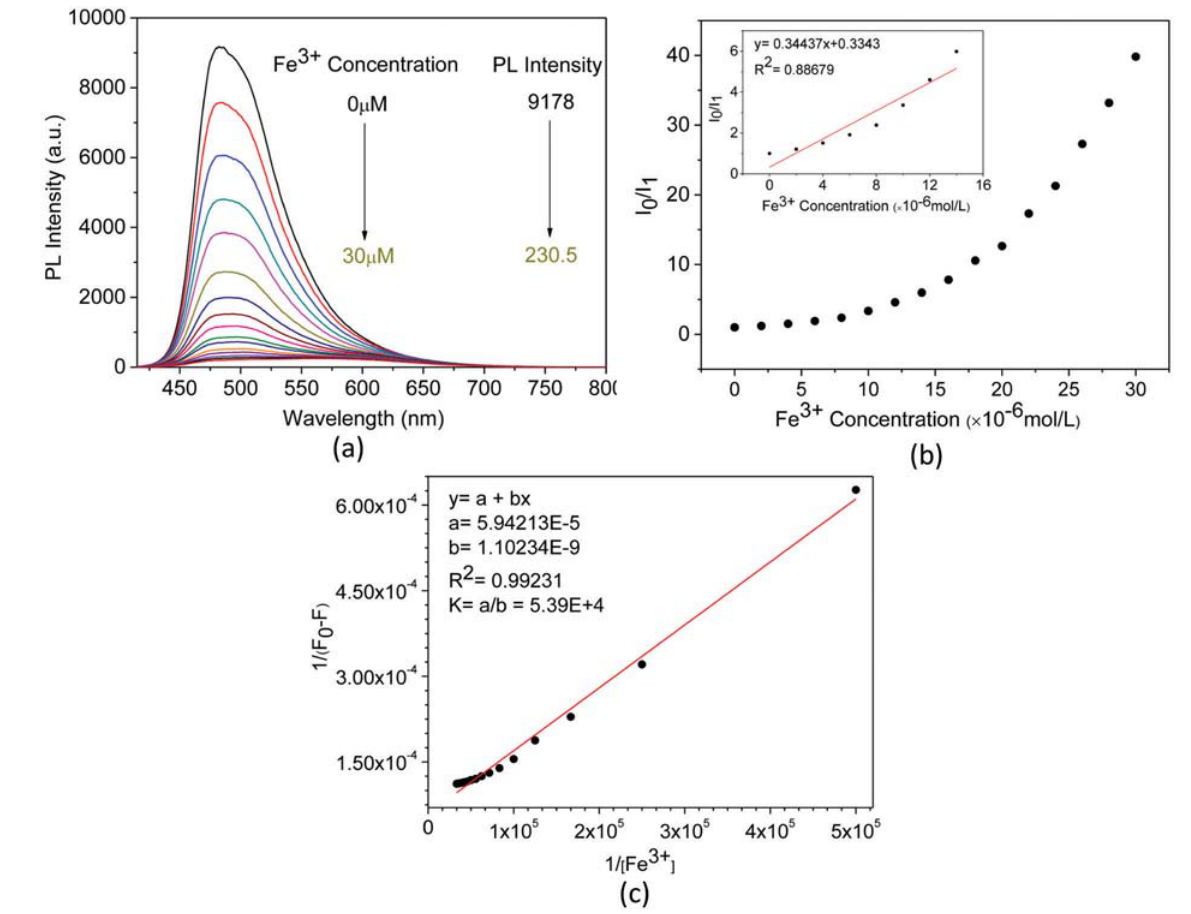
Figure 9: PL spectra of methanol solution of (-)-PPBIPV with different concentration of Fe 3+ (a); PL titration curves of methanol solution of (-)-PPBIPV with Fe 3+ (b); The Benesi-Hildebrand plot of methanol solution of (-)-PPBIPV with Fe 3+